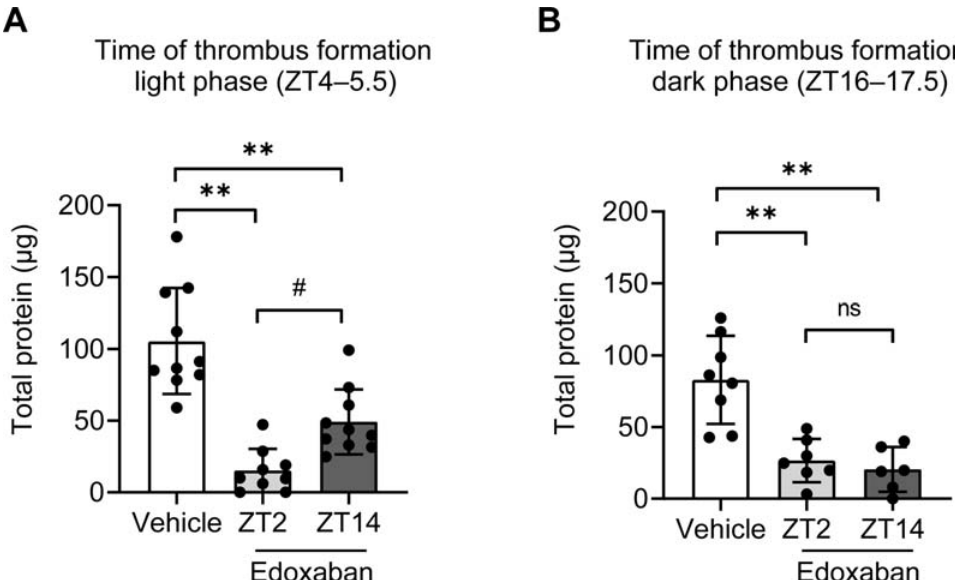
Fig.3 Dosing time-dependenteffectsofedoxabanonthrombusformation. Ratswereadministeredvehicle (whitebars) oredoxaban(10mg/kg) at zeitgeber time (ZT)-2 (light gray bars) or ZT14 (darkgray bars). Venous thrombosis formation was initiated at ( A ) 2 or ( B ) 14hours after dosing (i.e., at ZT4 or ZT16). The combined data from vehicle-administered rats at ZT2 or ZT14 are presented (white bars). Data represent the means (cid:3) standard deviation ( A , n ¼ 9 – 10; B , n ¼ 6 – 8). (cid:4)(cid:4) p < 0.01 versus the vehicle-administered group. # p < 0.05 versus edoxaban dosing in the ZT2 group. ns, not signi fi